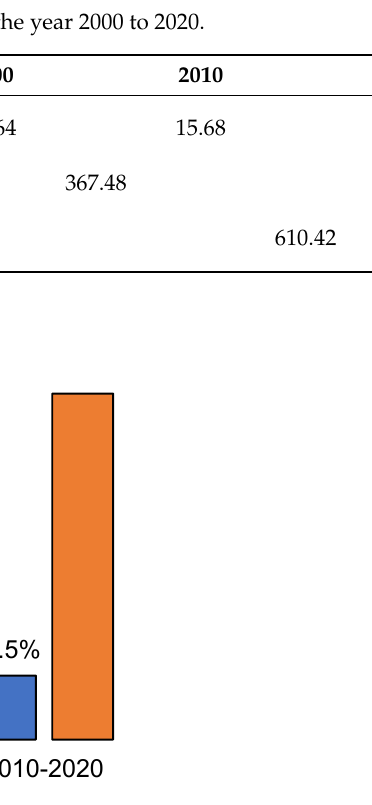
Figure 10. Carbon sinks contributed by new afforestation from 2000 to 2020.